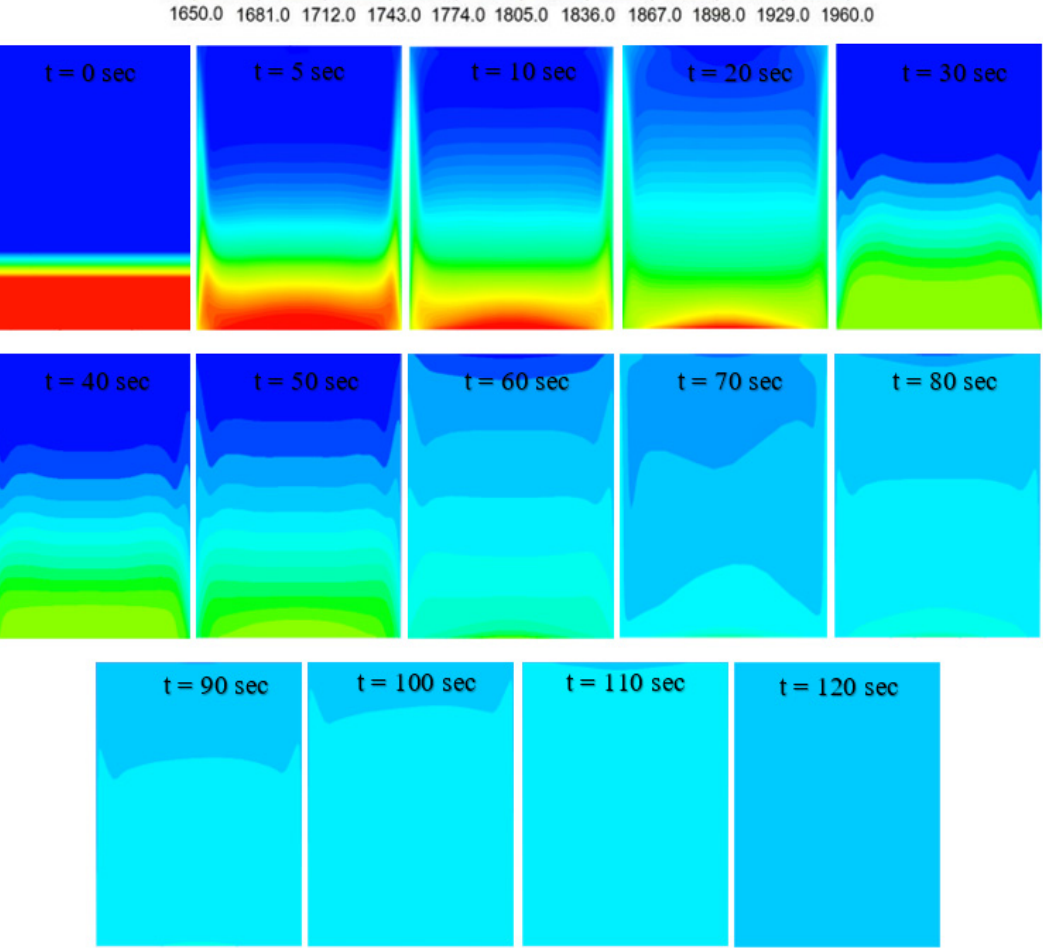
Figure 7. Plots of density contours from initial mass fraction distribution configuration (t = 0 s) to end time of the mixing process (t = 120 s).